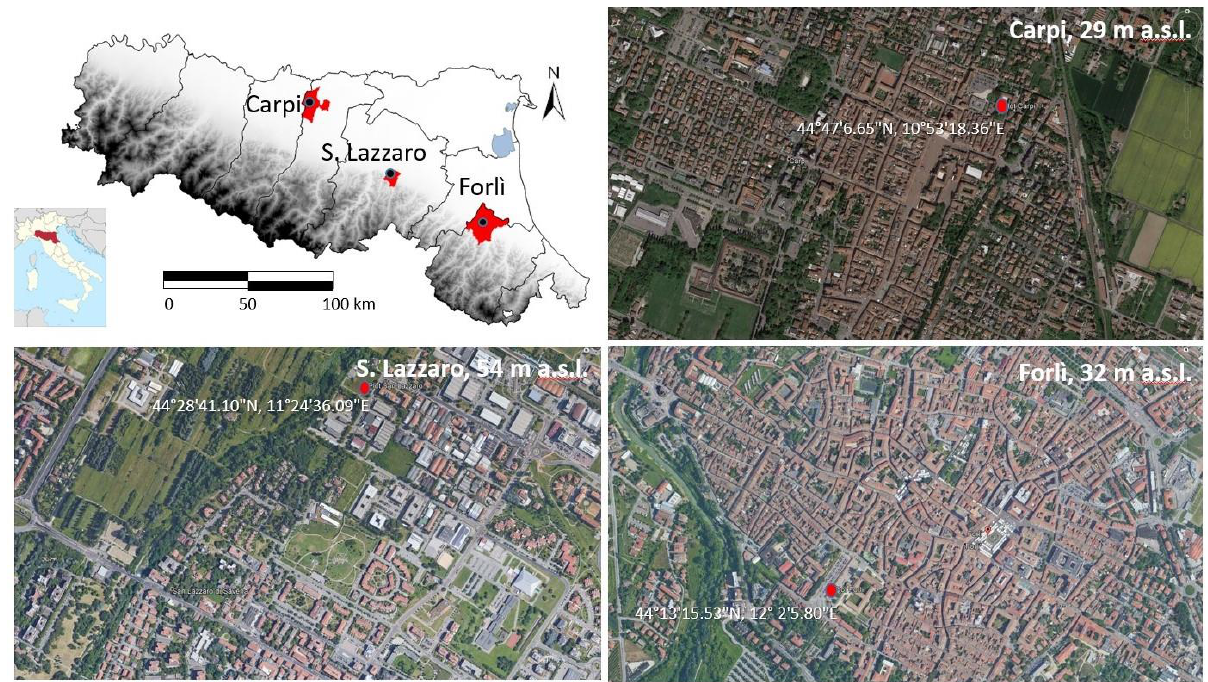
Figure 1. Map of Emilia Romagna region (Northern Italy) with geo-localization of sites subject to greening intervention, respectively, in Carpi (site 1, top right), Forlì (site 2, bottom right) and San Lazzaro (site 3, bottom left).